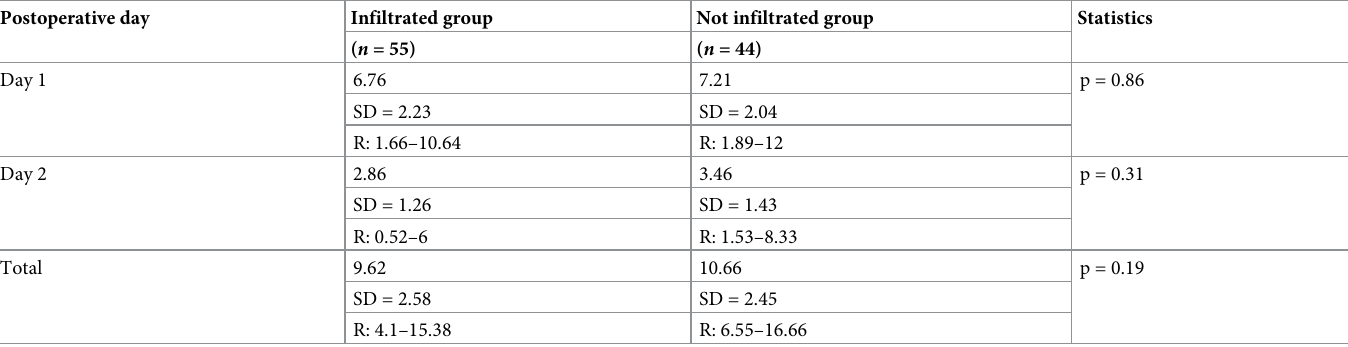
Table 5. Drainage output volume in milliliters corrected for acetabular size in millimeters (ratio: Drainage output volume/acetabular